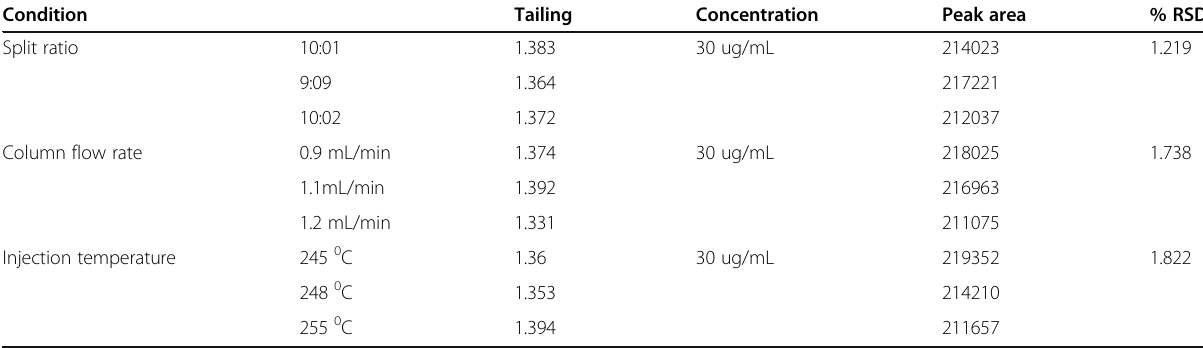
Table 9 Robustness result for